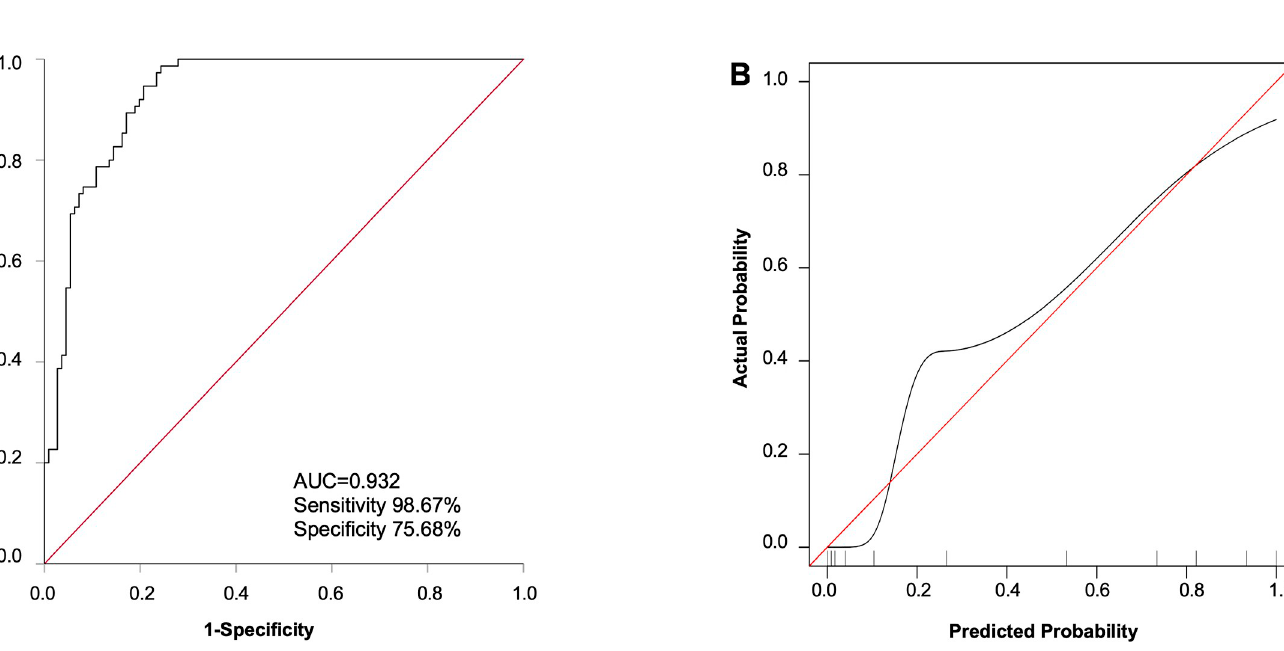
Fig 3. A. ROC curves of the age, cTnI, gender, and the presence of hypertension and diabetes for the identification of the severity of COVID-19. B. The calibration plot for the comparison of the predicted and actual probability. The X-axis and Y-axis represent the model-predicted and actual probability of MAE, respectively. The red line: perfect prediction. The black line: predictive performance of the model after bootstrapping (B = 1000 repetitions).